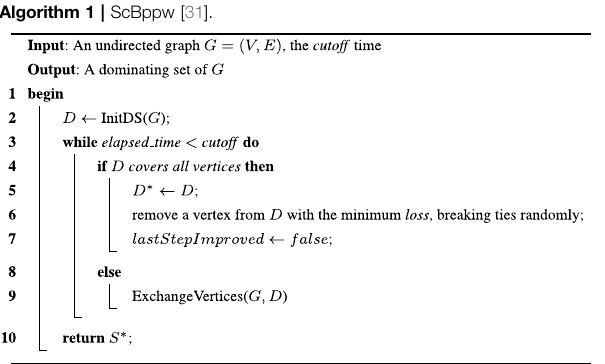
Algorithm 1 | ScBppw